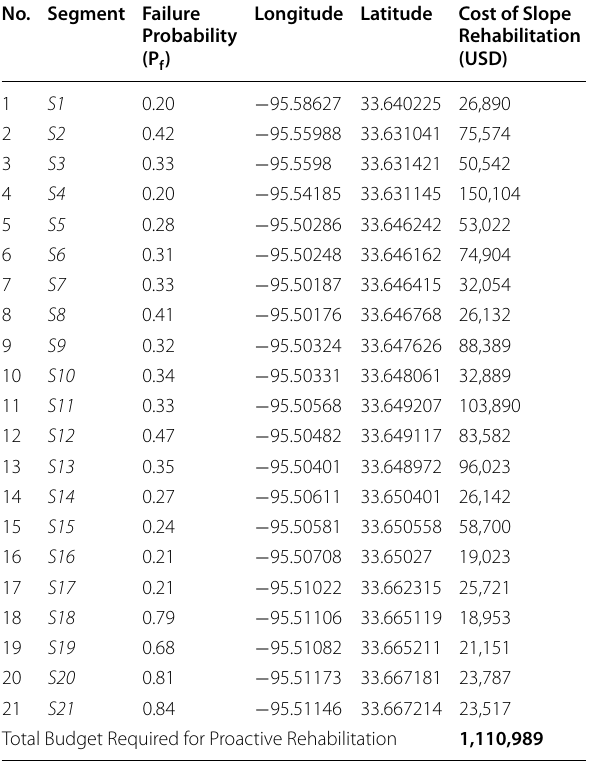
Table 1 Cost for rehabilitation/restoration of different slope segments